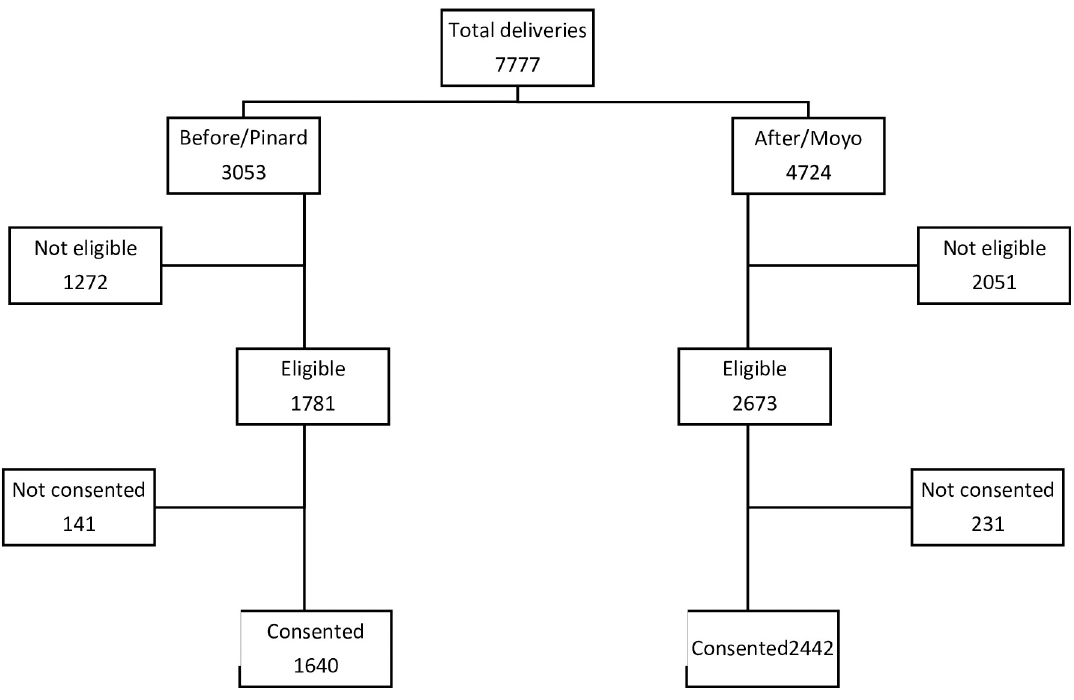
Fig 2. Flow chart of the study